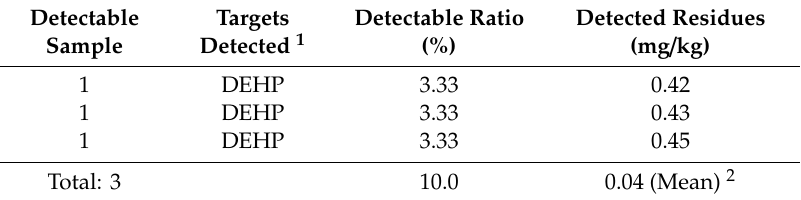
Table 3. Detection ratios of phthalates in chicken samples (n = 30) collected during 2016.